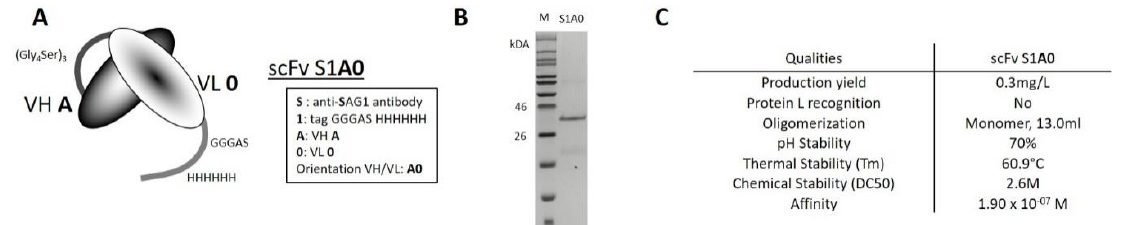
Figure 1. Structural and functional characterization of original wild-type single-chain Fragment variable (scFv). ( A ) Schematic representation of recombinant scFv S1A0 with structural features and nomenclature. ScFv S1A0 was constructed from the association of the heavy (VH A) and light (VL 0) variable wild-type domains of anti-SAG1 (“S”) antibody and the inclusion of peptide flag Gly 3 AlaSerHis 6 in C-terminal (“1”). ( B ) Coomassie-stained sodium dodecyl sulfate-polyacrylamide gel electrophoresis (SDS-PAGE) for analysis of purified scFv S1A0 under reducing conditions. M: Molecular marker. ( C ) Production yield and biophysical properties of scFv S1A0.